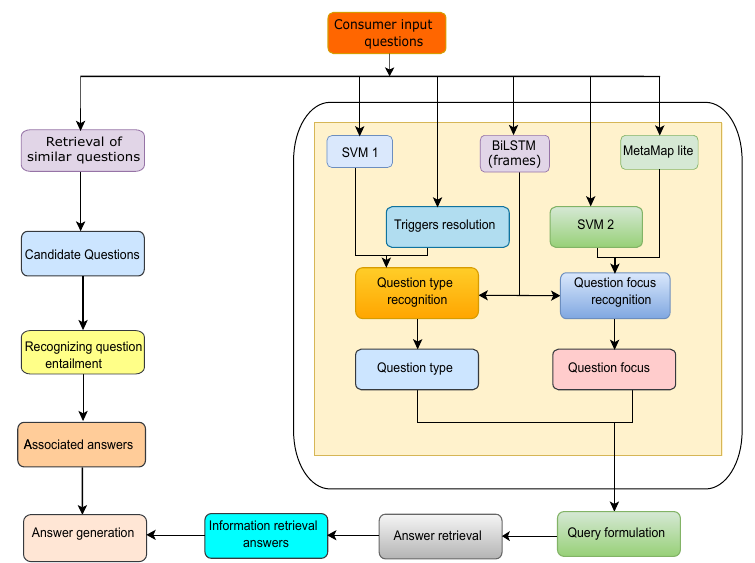
Figure 6. CHiQA’s system architecture